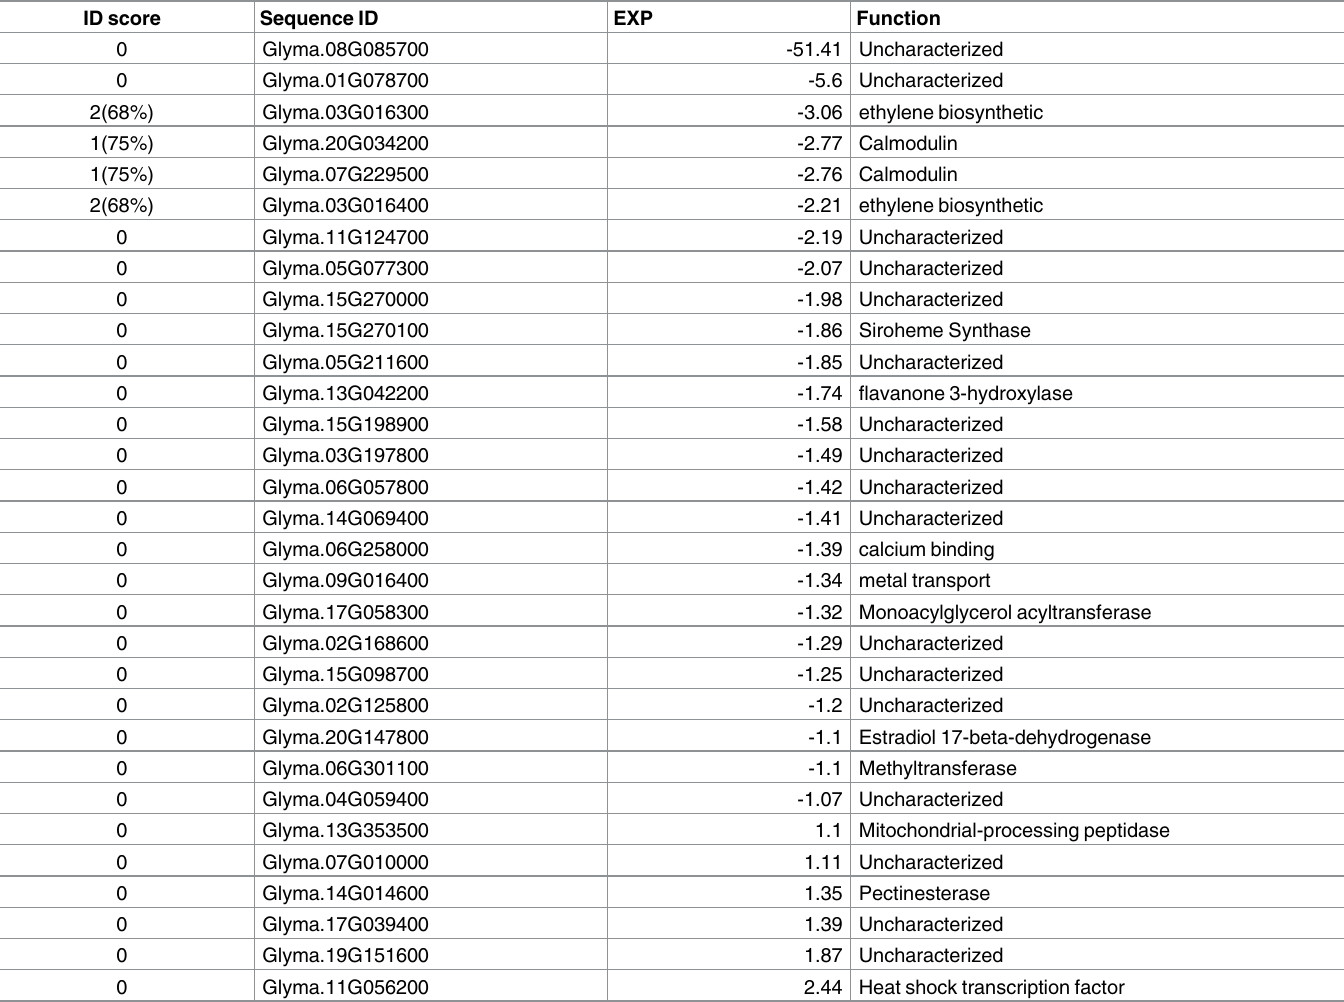
Table 6. Non-additive gene expressionin